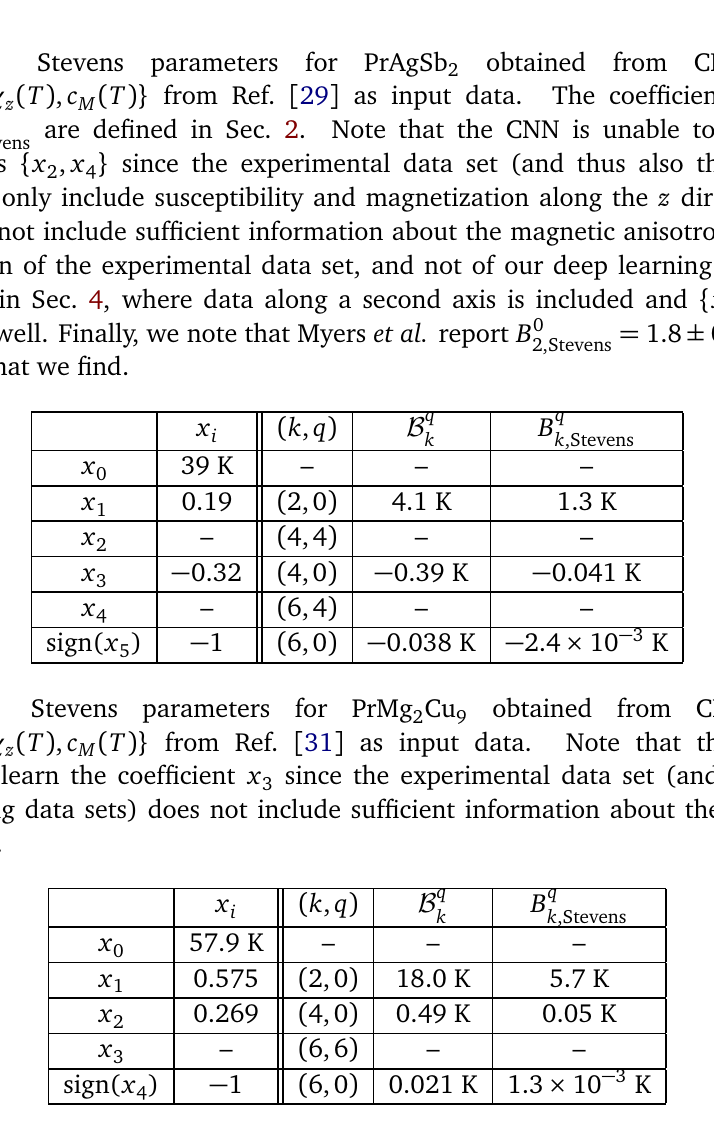
SciPost Phys. 11, 011 (2021)